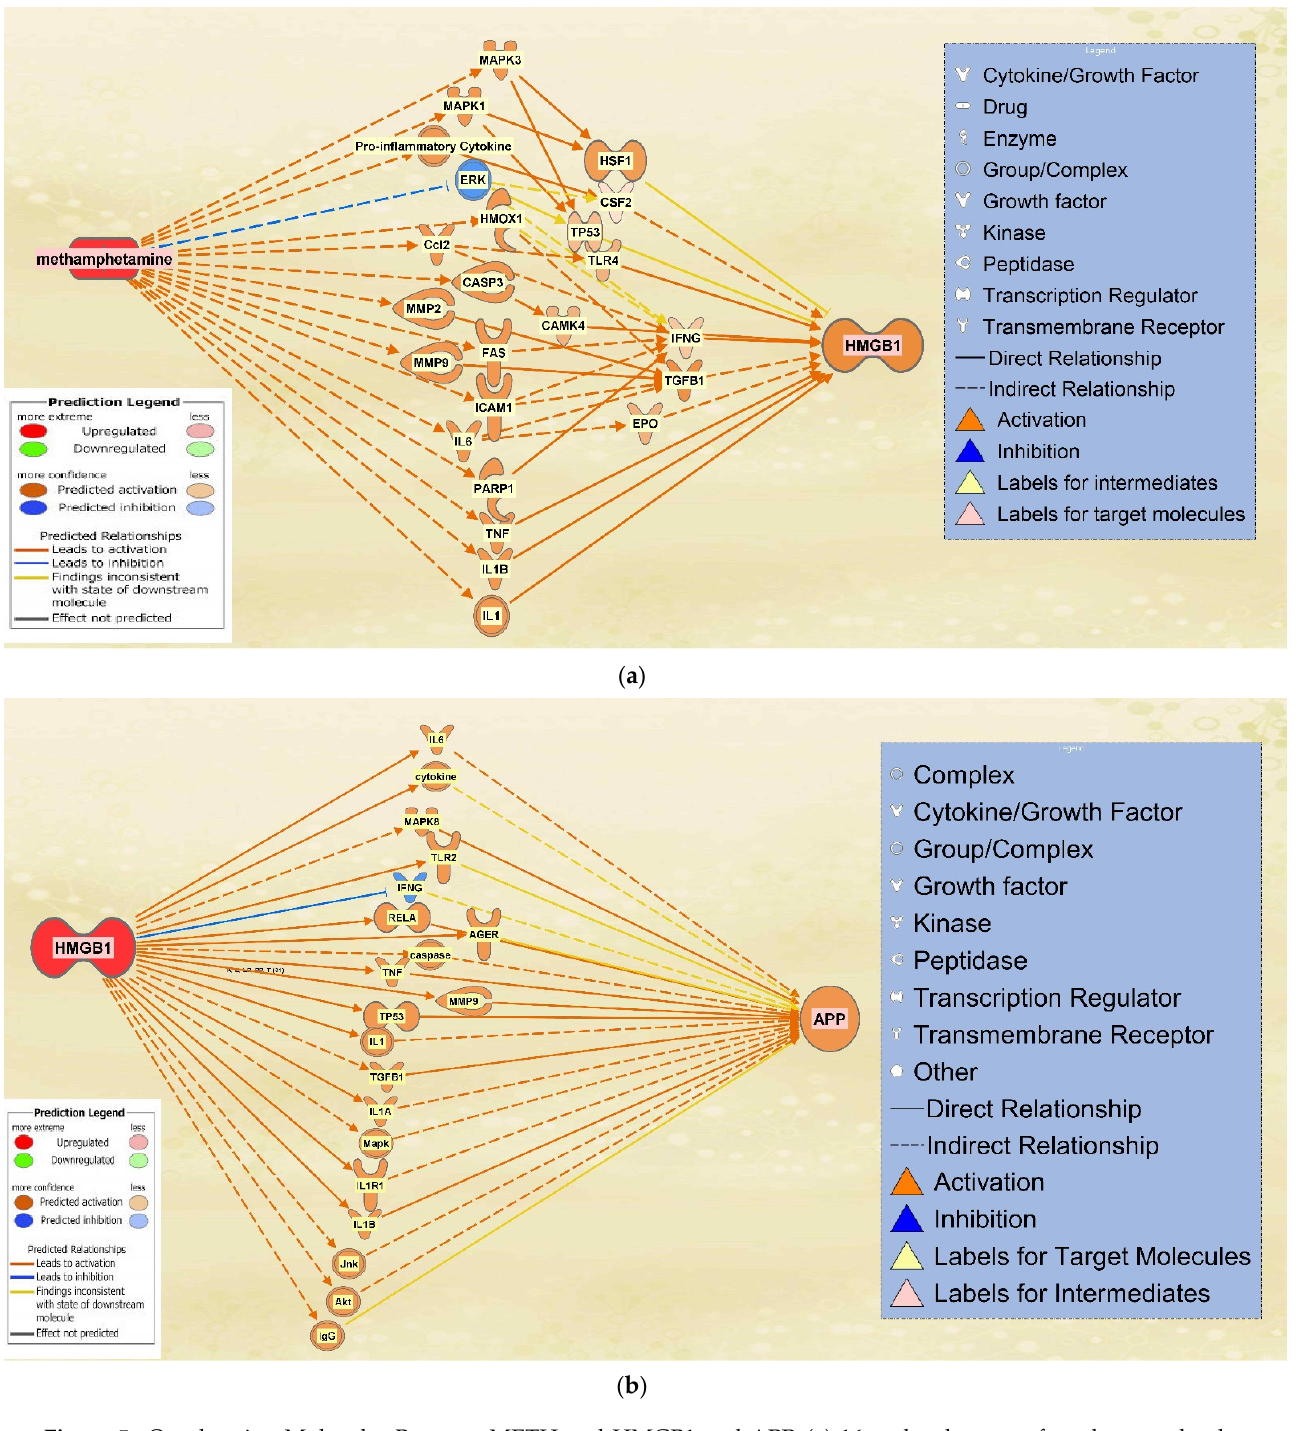
Figure 5. Overlapping Molecules Between METH and HMGB1 and APP. ( a ) 16 molecules were found to overlap between METH and HMGB1. These intermediates are affected by METH exposure and also influence HMGB1 expression; ( b ) 19 molecules were found to overlap between HMGB1 and APP. These intermediates influence APP expression upon the upregulation of HMGB1.